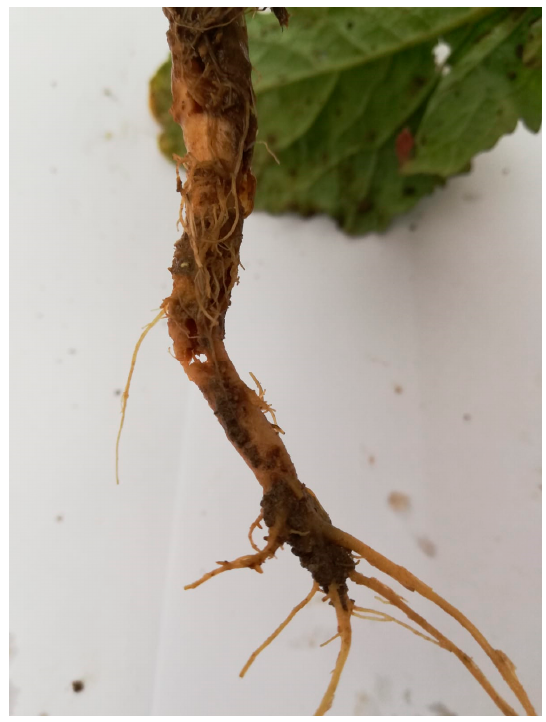
Figure 2. Damage caused by D. radicum on the root of the Brassicaceae hybrid.